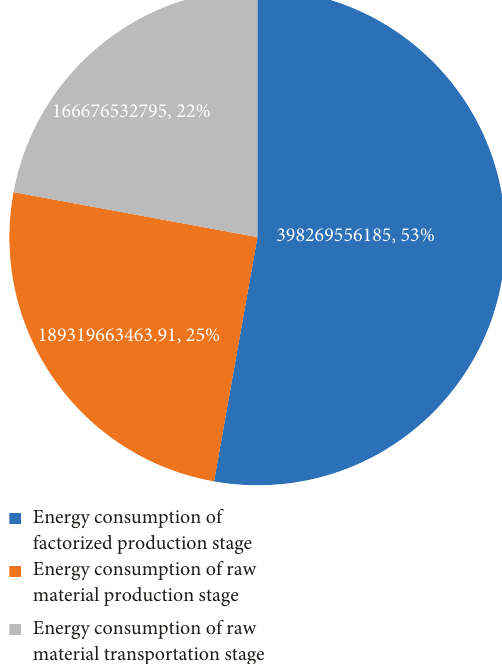
Figure 14: Total energy consumption of prefabricated column